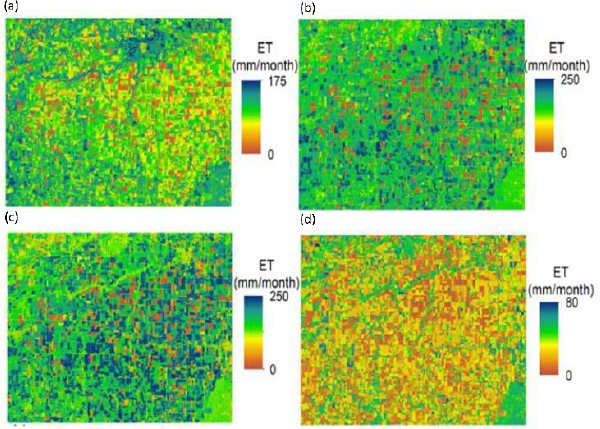
Figure 3. Spatial monthly average ET rate for: a) June; b) July; c) August; d) October 2016.